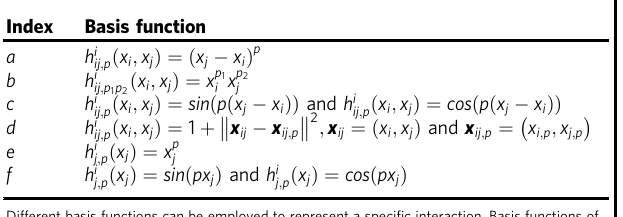
Table 1 Interactions may be represented in different basis